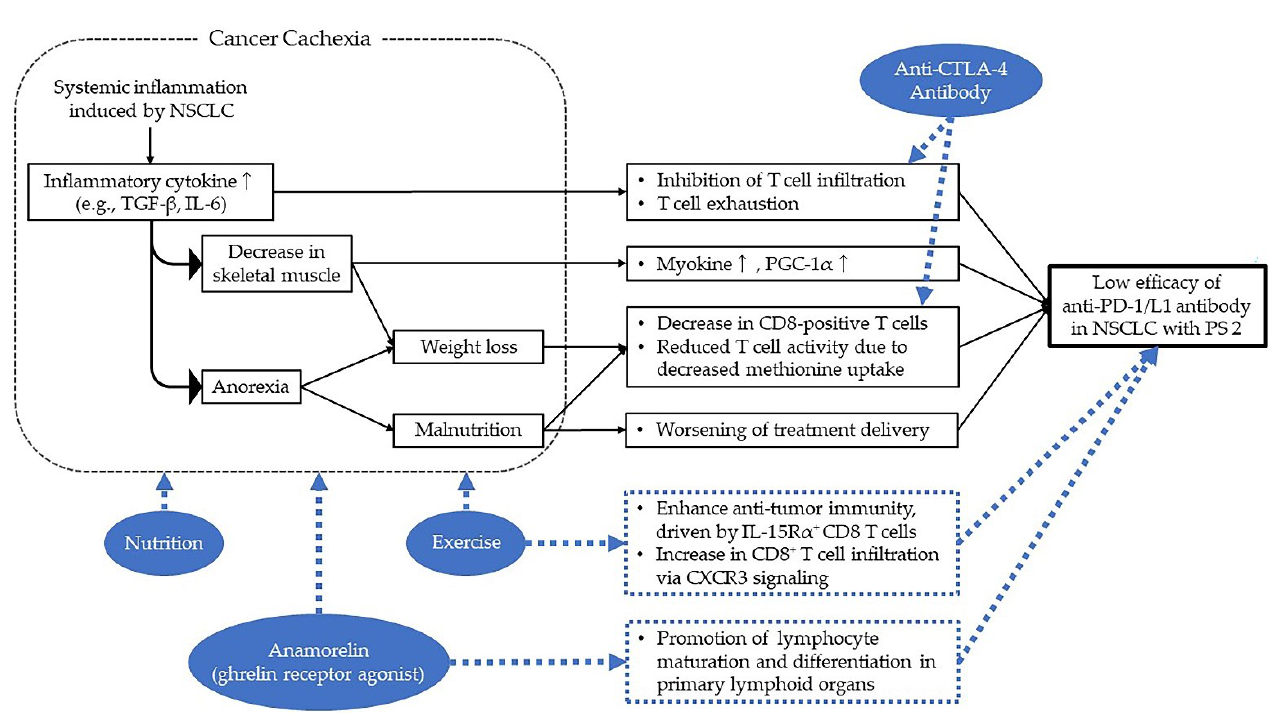
Figure 1. Possible causes and potential treatments for low efficacy of ICI in NSCLC with PS 2. Ab- breviations: NSCLC, non-small cell lung cancer; ICI, immune checkpoint inhibitor; PS, performance status; PD-1, Programmed cell Death-1; PD-L1, Programmed cell Death-1 Ligand 1; CTLA, Cytotoxic T lymphocyte-associated antigen.